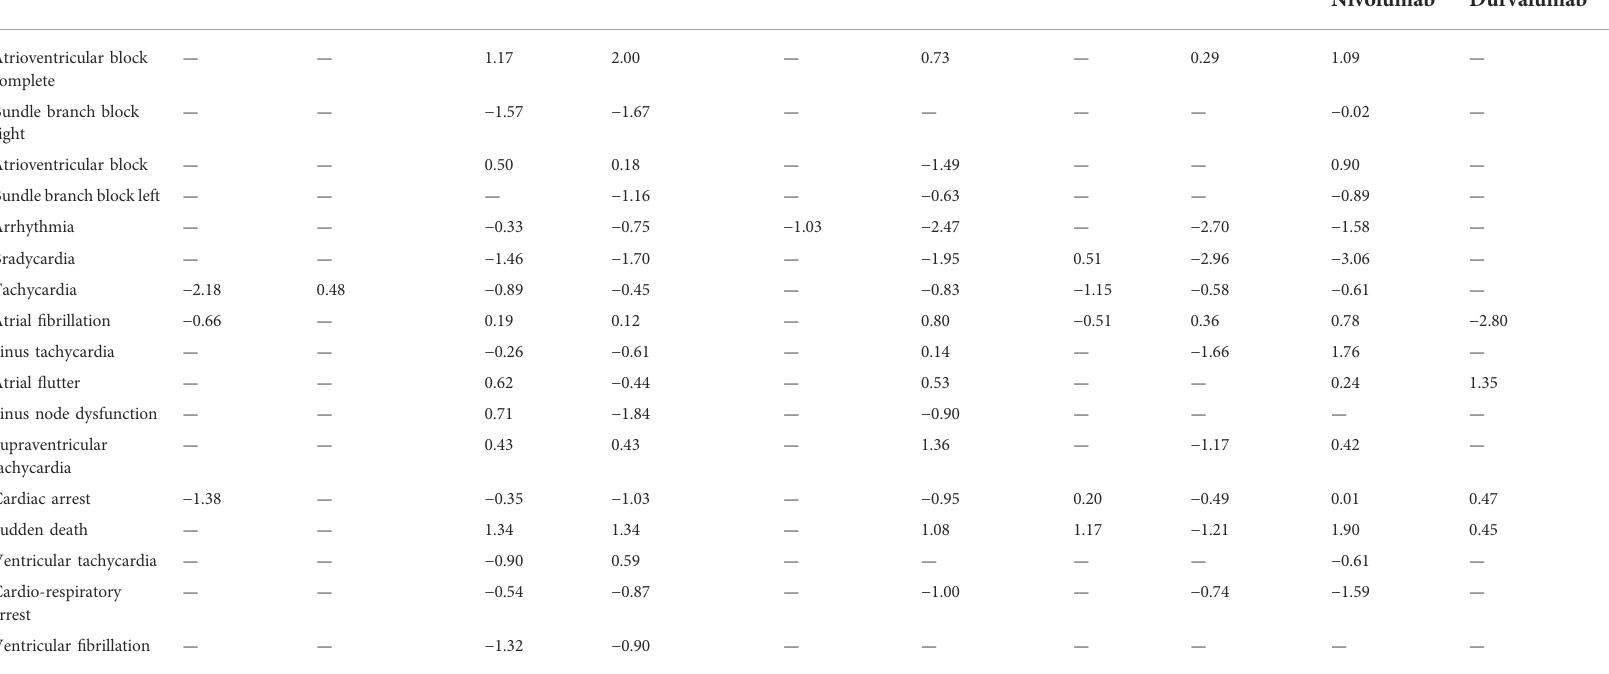
TABLE 3 Arrhythmia Signal Pro fi les of Different ICI Strategies. IC 025 >0